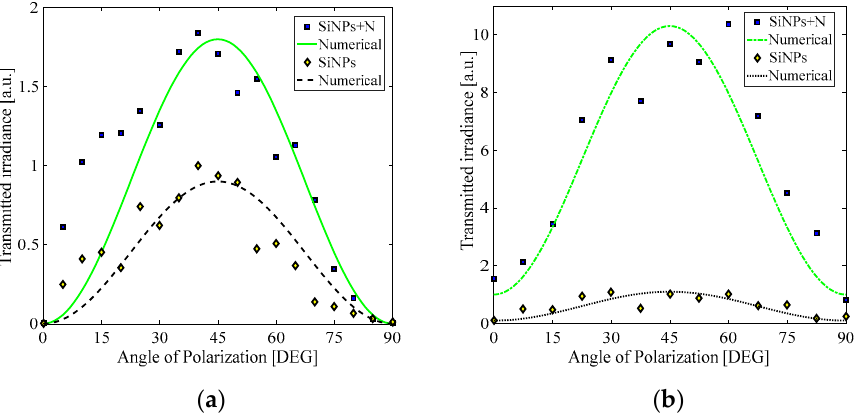
Figure 4. Kerr transmittance at 532 nm by ( a ) nanosecond pulses and ( b ) picosecond pulses. The effective third-order nonlinear susceptibilities estimated for each sample are presented in Table 1. For picosecond pulses, there is a 3-fold increase in the third-order susceptibility for the SiNPs+N sample with respect to the SiNPs sample. Table 1. Effective χ (3) susceptibility estimated from the results in Figure 4 for the SiNPs and SiNPs+N samples at 532 nm.